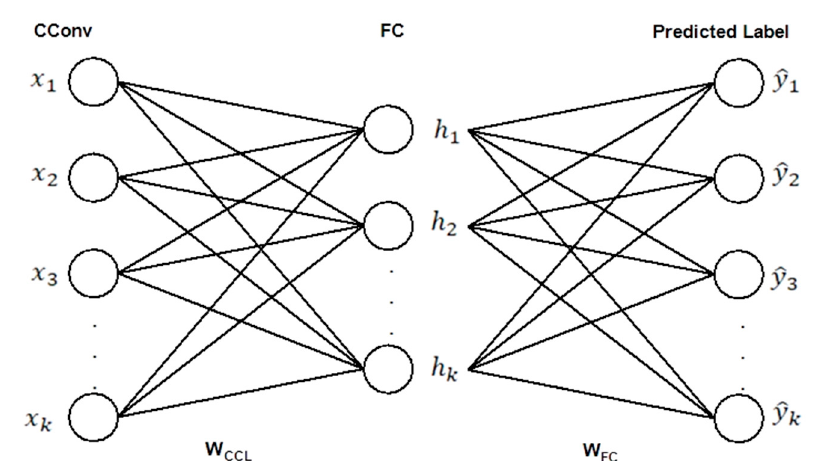
Figure 3. Flowchart of updating the parameters of fully connected (FC Layer) and Softmax layers.